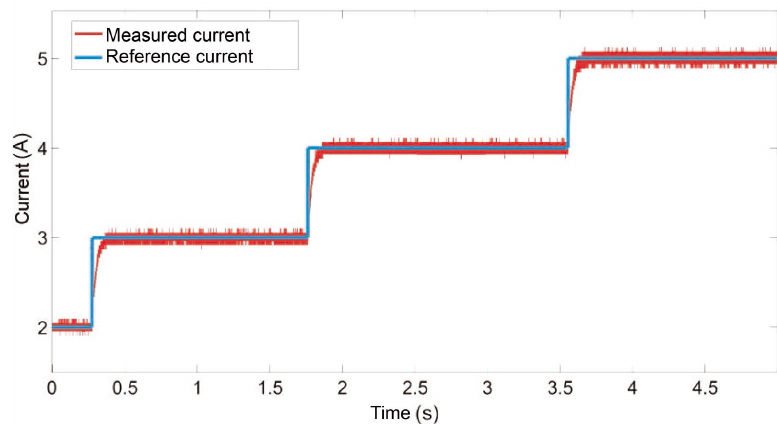
Figure 12. Variable DC current reference test.